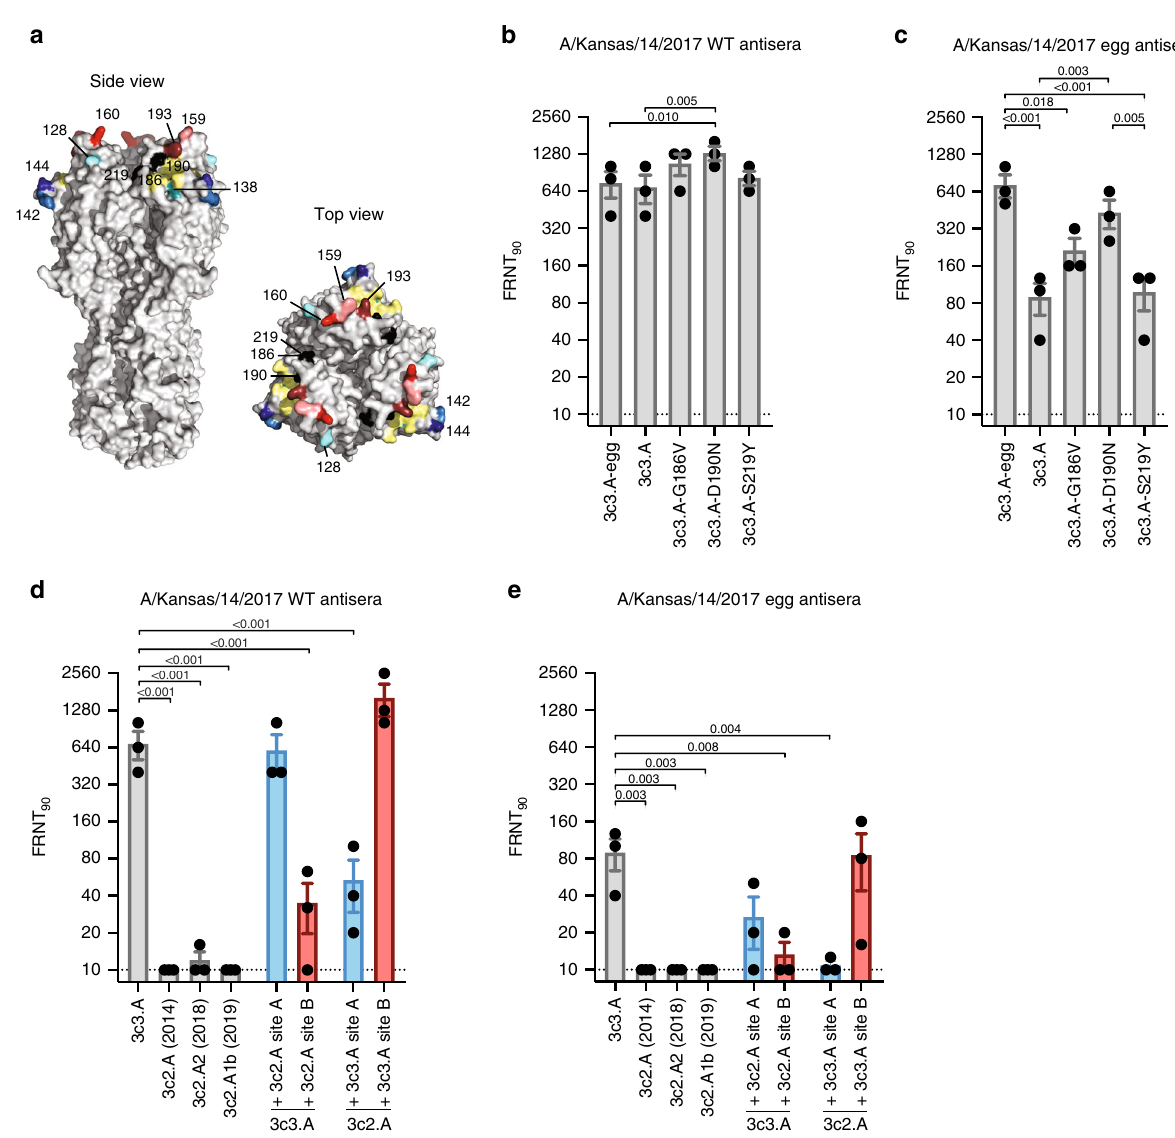
Fig. 1 Antigenic mismatch of the H3N2 component of the 2019 – 2020 Northern Hemisphere in fl uenza vaccine. a Crystal structure of the HA trimer of A/ Victoria/361/2011 (PDB accession code 4O5I) with the amino acid substitutions that differ between egg-adapted and wild-type A/Kansas/14/2017 (positions 186, 190, and 219) shown in black and the amino acid substitutions that differ between wild-type A/Kansas/14/2017 and other 3c2.A H3N2 subclades in antigenic sites A (positions 128, 138, 142, and 144) and B (positions 159, 160, and 193) shown in blue and red, respectively. The receptor-binding pocket is indicated in yellow. b Neutralizing antibody titers (FRNT 90 ) to wild-type A/Kansas/14/2017 (3c3.A) and egg-adapted A/ Kansas/14/2017 (3c3.A-egg) using wild-type A/Kansas/14/2017 antisera ( n = 3 ferrets, each data point represents the geometric mean titer from three independent experiments). Data are presented as mean ± SEM. Log 2 -transformed antibody titers were compared using RM one-way ANOVA corrected for multiple comparisons (Bonferroni method). P -values < 0.05 are indicated. c Neutralizing antibody titers (FRNT 90 ) to wild-type A/Kansas/14/2017 (3c3.A) and egg-adapted A/Kansas/14/2017 (3c3.A-egg) using egg-adapted A/Kansas/14/2017 antisera ( n = 3 ferrets, each data point represents the geometric mean titer from three independent experiments). Data are presented as mean ± SEM. Log 2 -transformed antibody titers were compared using RM one-way ANOVA corrected for multiple comparisons (Bonferroni method). P -values < 0.05 are indicated. d , e Neutralizing antibody titers (FRNT 90 ) to a panel of H3N2 viruses using wild-type A/Kansas/14/2017 and egg-adapted A/Kansas/14/2017 antisera ( n = 3 ferrets per group, each data point represents the geometric mean titer from three independent experiments). 3c3.A virus with 3c2.A site A possesses amino acid substitutions A128T, S138A, G142R, and K144S. 3c3.A virus with 3c2.A site B possesses amino acid substitutions S159Y, K160T, and S193F. 3c2.A virus with 3c3.A site A possesses amino acid substitutions T128A, A138S, R142G, and S144K. 3c2.A virus with 3c3.A site B possesses amino acid substitutions Y159S, T160K, and F193S. Data are presented as mean ± SEM. Log 2 -transformed antibody titers were compared using RM one-way ANOVA corrected for multiple comparisons (Bonferroni method). Signi fi cant differences relative to 3c3.A are indicated ( p < 0.05). Source data are provided as a Source Data fi Methods type HA (Fig. 1a). All 3c3.A viruses were rescued using wild-type A/Kansas/14/2017 Viruses . We used reverse genetics 3 to create viruses for this study. For ferret infec- NA (GISAID accession number EPI1146344). Other viruses in our panel included HAs from A/Colorado/15/2014 (3c2.A, GISAID accession number EPI545672), A/ tions, we created 3c3.A viruses with the wild-type or egg-adapted A/Kansas/14/2017 North Carolina/28/2019 (3c2.A1b, GISAID accession number EPI1606044), or A/ HA (GISAID accession numbers EPI1146345 and EPI1444535). The egg-adapted HA Pennsylvania/49/2018 (3c2.A2, GISAID accession number EPI1197412). NA from A/ possessed amino acid substitutions G186V, D190N, and S219Y relative to the wild-